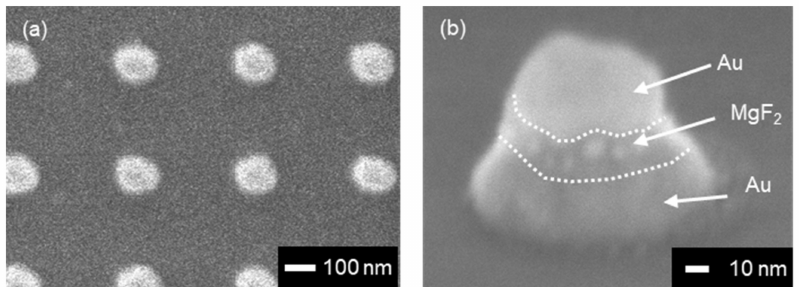
Figure 5. Scanning electron microscopy (SEM) images of the fabricated MIM nanostructures observed from ( a ) the top and ( b ) the side.